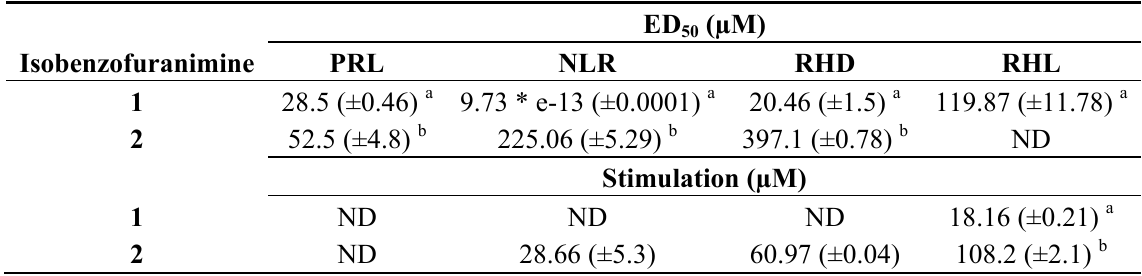
Table 1. ED (µM) values and stimulatory concentrations (µM) of primary root length 50 (PRL), number of lateral root (NLR), root hair density (RHD) and root hair length (RHL) of A. thaliana estimated by the log-logistic equations in response to different concentrations of compounds 1 and 2 . Data from Figures 1–4. Different letters along the columns, for each parameter, indicate significant differences at p < 0.05 (Tukey’s test). Values within the brackets indicated the standard deviation ( N = 5). All the dose-response curves pointed out a significance level of p <